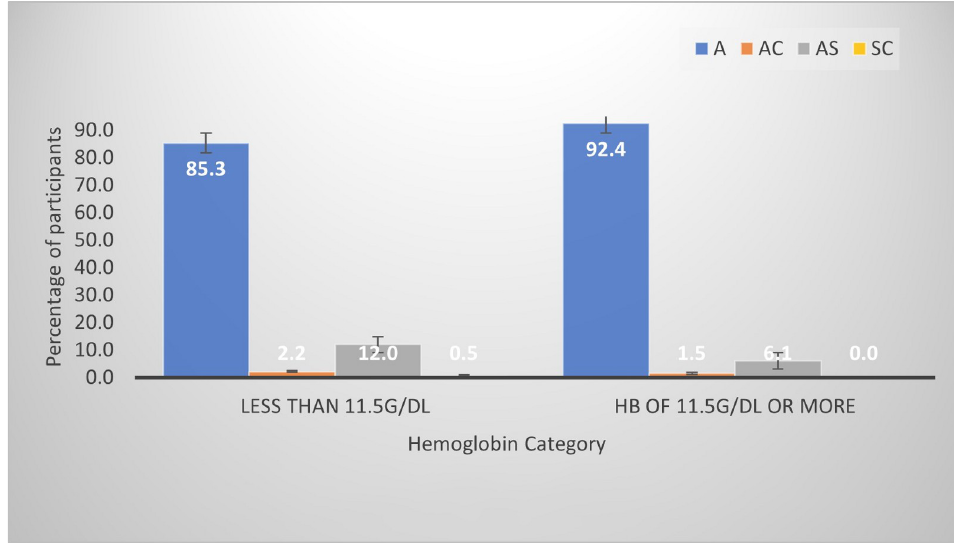
Fig 2. Incidence of anemia among the various hemoglobin variants observed in the subjects.